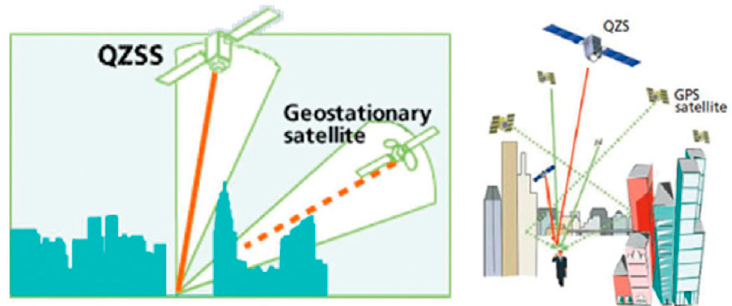
Figure 1. Seamless service of Quasi-Zenith Satellite System (QZSS) system and GPS system. Table 1. QZSS system broadcast signals and modulation